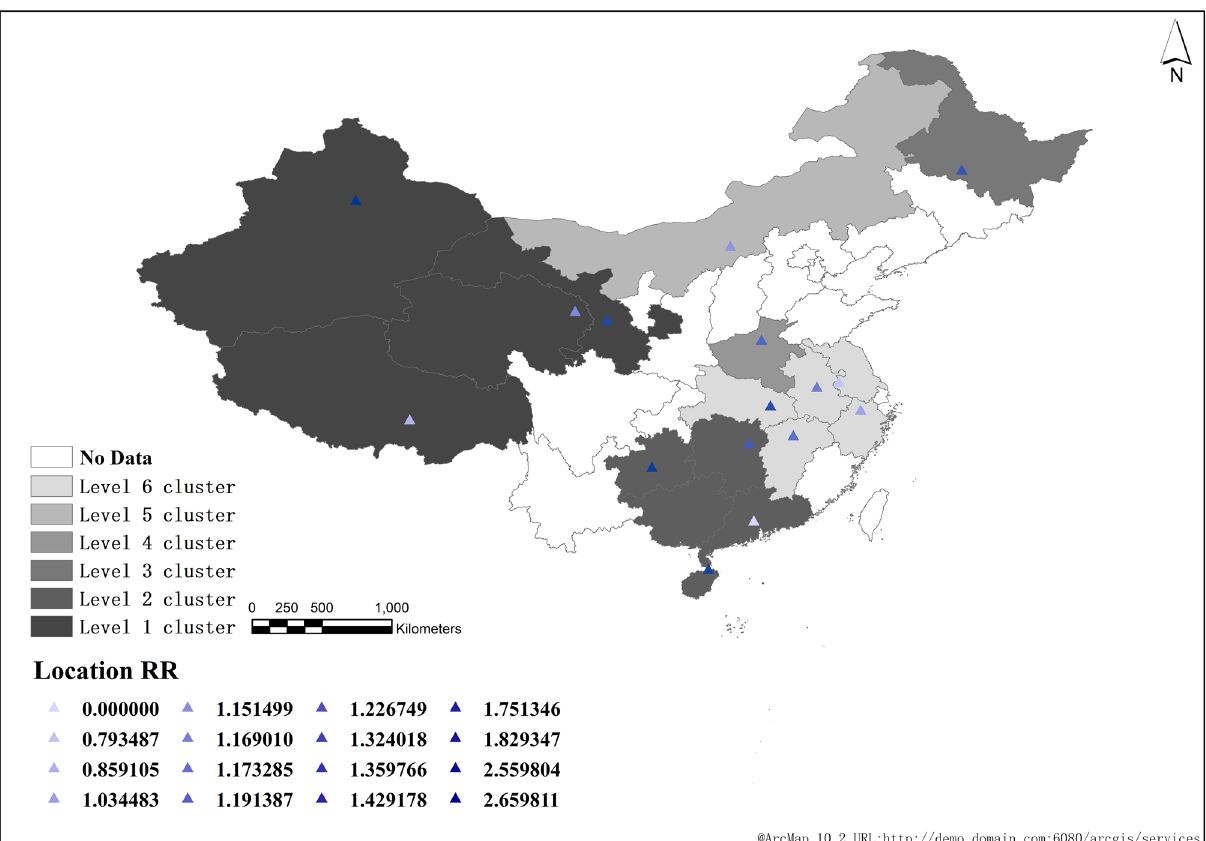
Figure 5. Space–time scanning analysis of reported cases of pulmonary tuberculosis in China from 2008 to